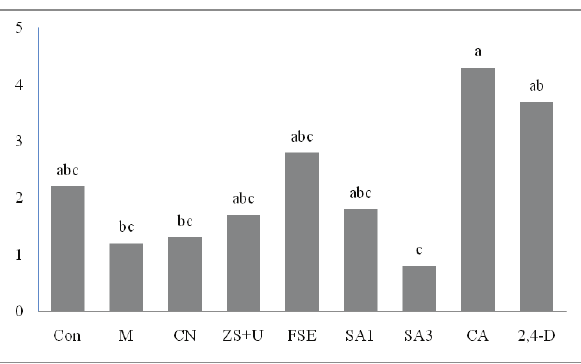
Figure 2: Effect of foliar-applied methanol (M), calcium nitrate (CN), zinc sulfate + urea (ZS+U), fermented sugarcane extract (FSE), sali- cylic acid 1 and 3 mM (SA1 and SA3), citric acid (CA), 2,4-dichloro- phenoxyacetic acid (2,4-D) and water (Con) on fruit weight loss (%) of ‘Thompson Navel’ orange. Differences in column headings denote statistically significant treatment effects (P< 0.05)